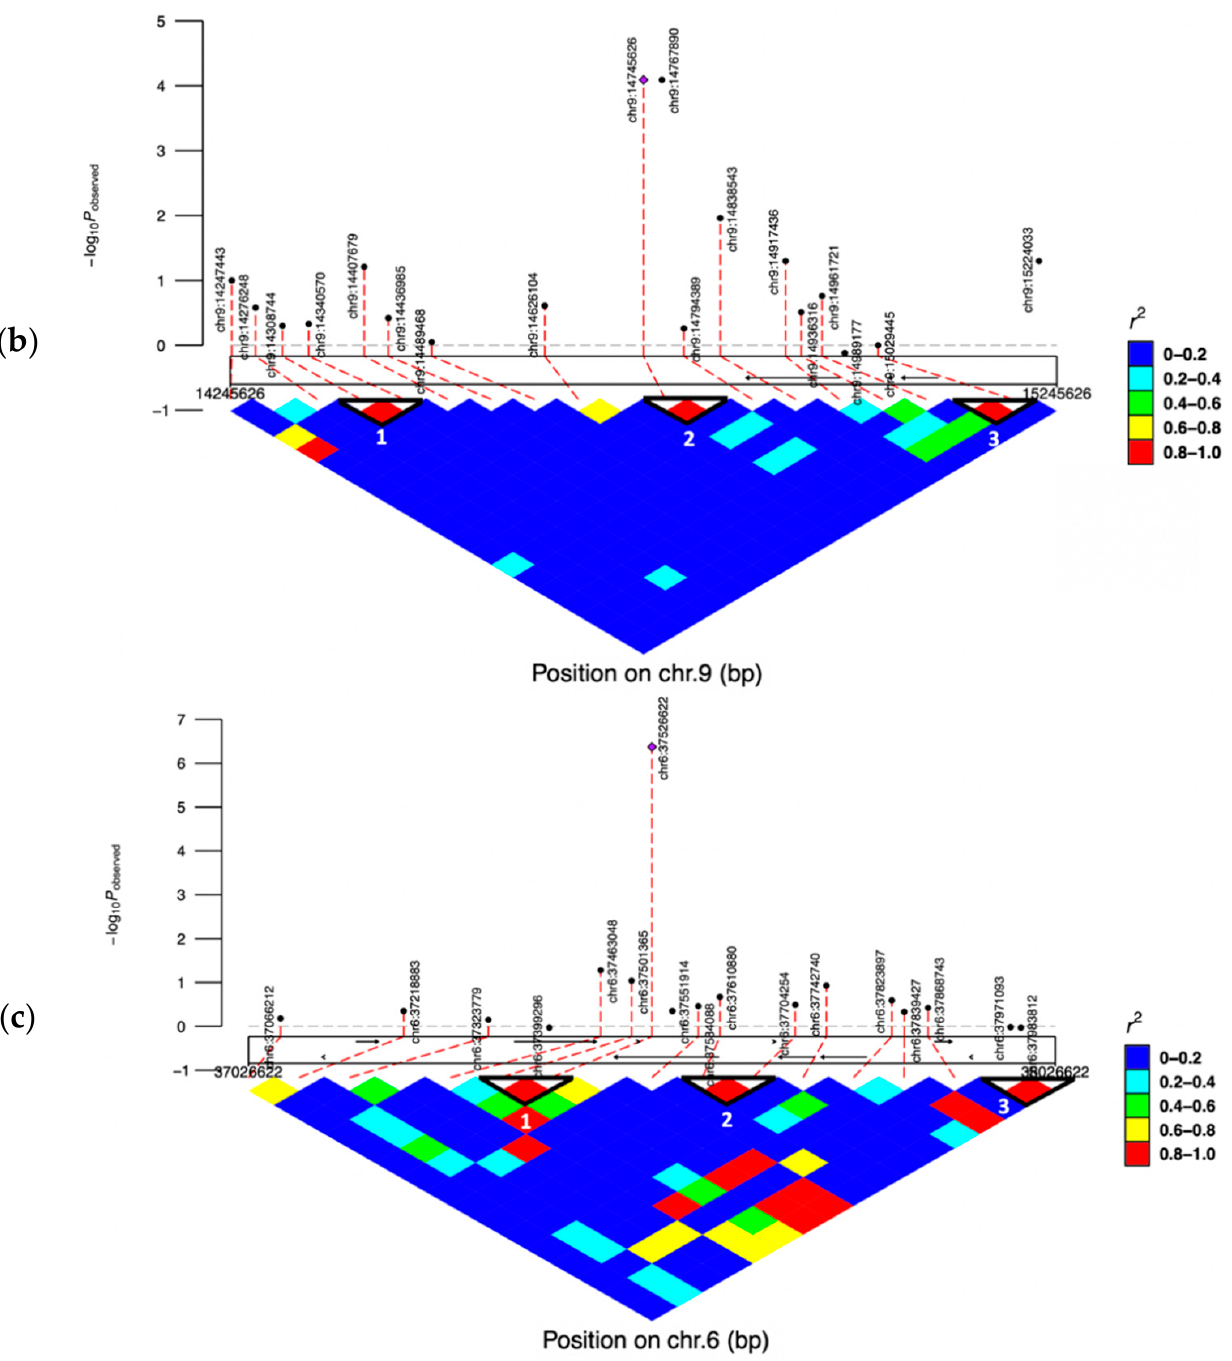
Figure 3. Linkage disequilibrium (LD) analysis. Solid line triangles refer to blocks of high linkage disequilibrium. The color of one square refers to the LD level ( r 2 ) between two SNPs. ( a ) LD pattern for 17 SNPs in the region between 7,772,794 to 8,772,794 Bp on chromosome 7; ( b ) LD pattern for 20 SNPs in the region between 14,245,626 to 15,245,626 Bp on chromosome 9; ( c ) LD pattern for 17 SNPs in the region between 37,026,622 to 38,026,622 Bp on chromosome 6.